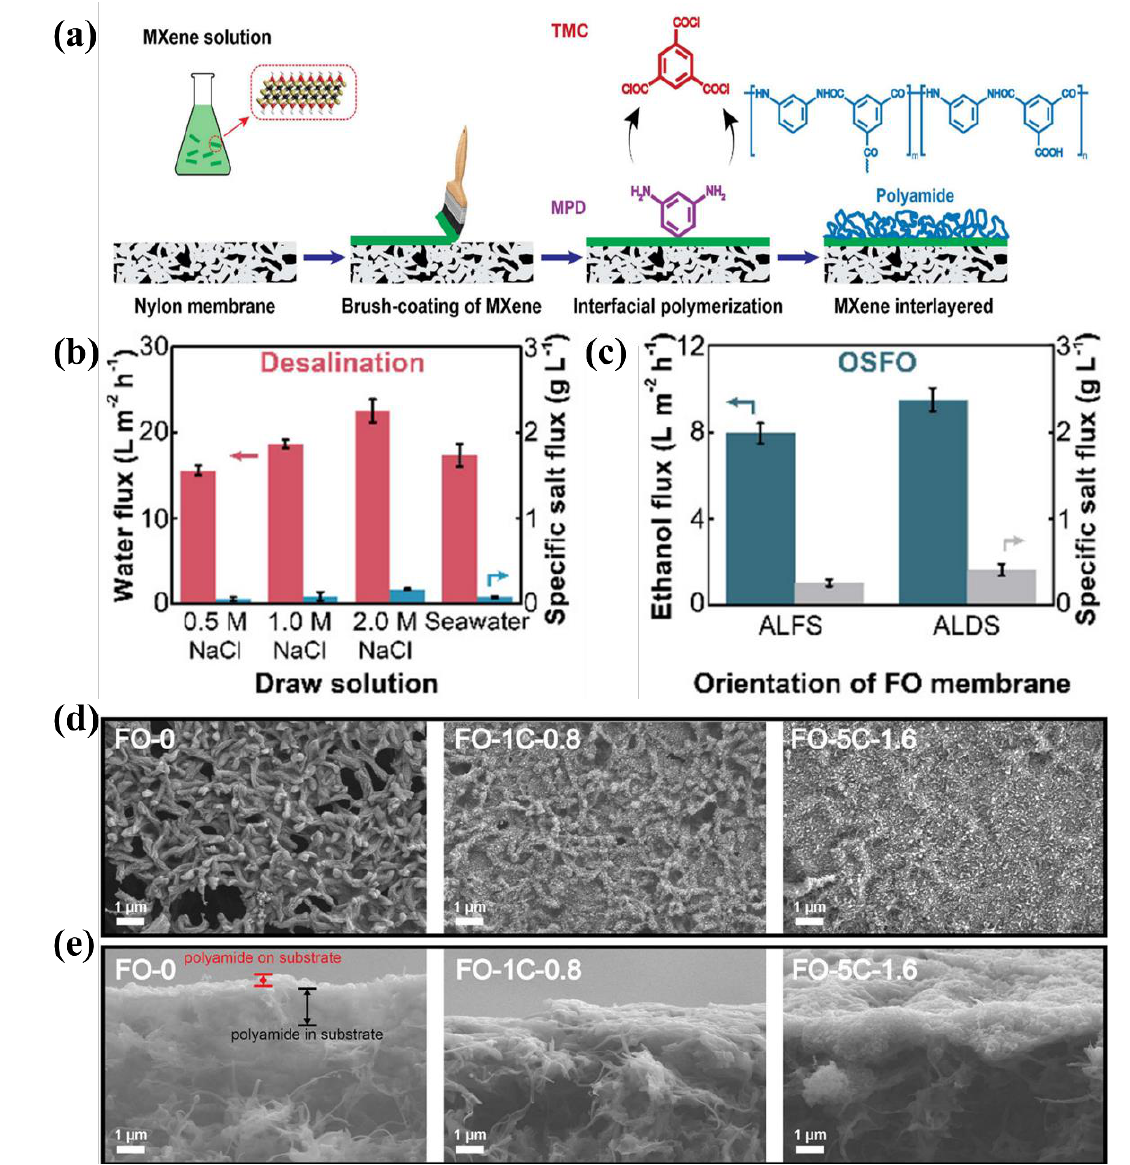
Figure 3. ( a ) Schematic of the fabrication of the TFNi FO membrane with MXene interlayer on the surface of commercial nylon membranes, ( b ) water flux and specific salt flux of the FO-1C-0.8 membrane with different draw solutions in the FO mode, ( c ) ethanol flux and specific salt flux of the FO-1C-0.8 membrane in an organic solvent FO test. ( d ) Surface and ( e ) cross-sectional SEM images of the TFNi FO membrane with MXene interlayer (FO-0 and FO-1C-0.8 membranes, where the numbers represent the coated 0 or 1 times at 0.8 mg L − 1 concentration of MXene solution), Reproduced with permission from Wu et al. [68], with copyright permission from © 2020 American Chemical